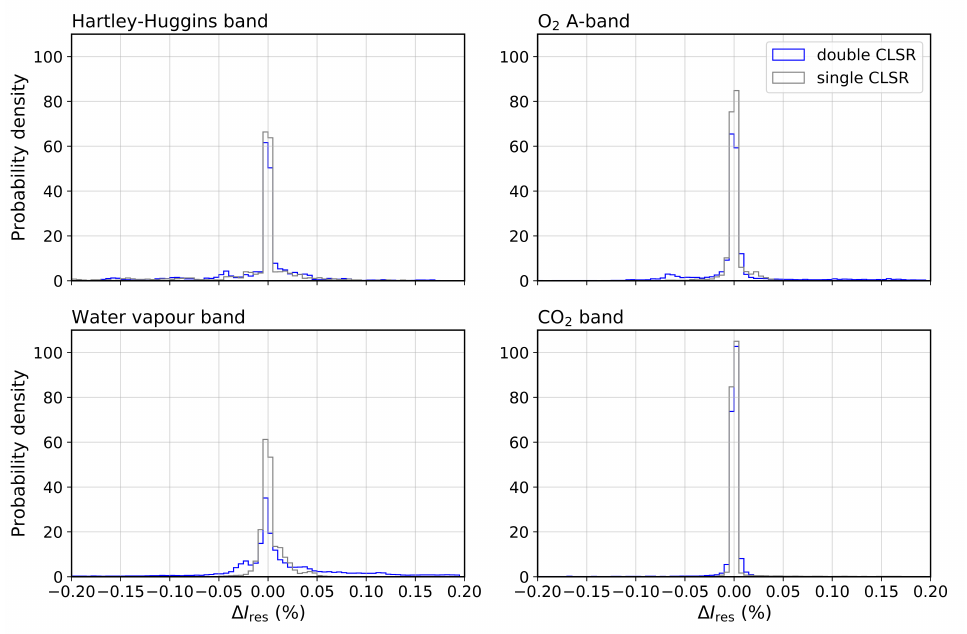
Figure 4. Probability density function of the residuals for the single CLSR (grey) and the double CLSR (blue) methods for the Hartley–Huggins, O 2 A-, water vapour and CO 2 bands and for the tropospheric aerosol